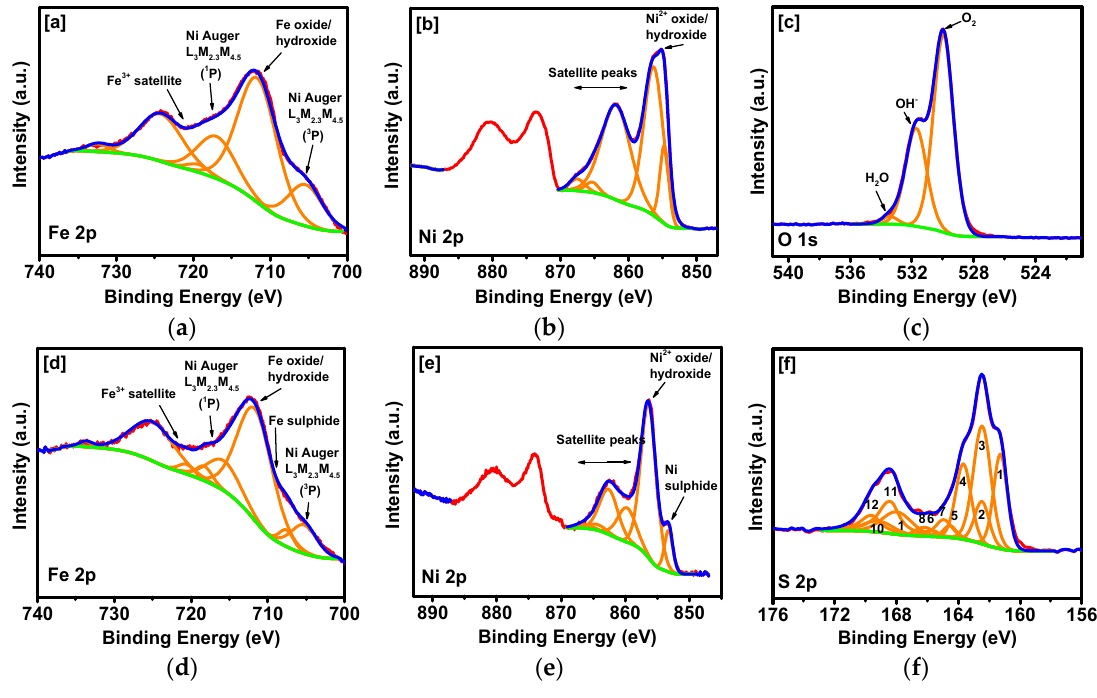
Figure 2. Peak-fitted XPS spectra of ( a – c ) FeNiO and ( d – f ) FeNiS.